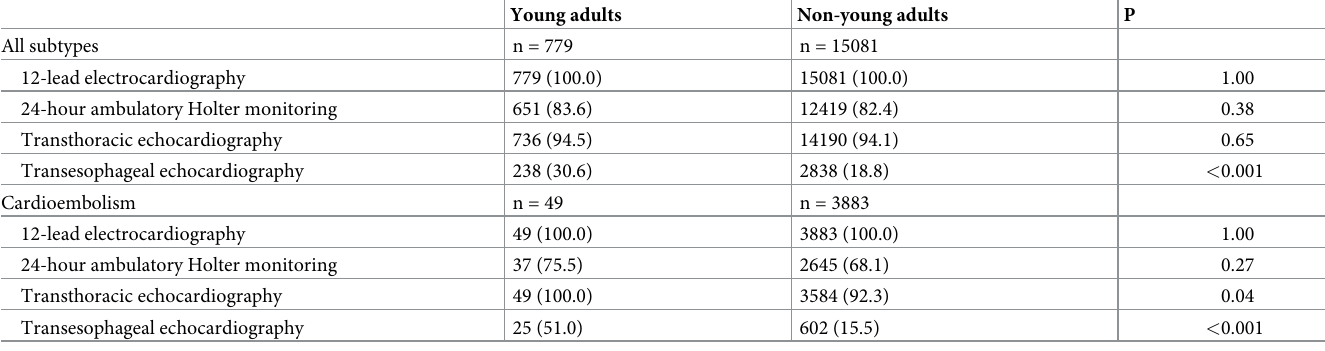
adults (Fig 3, S2 Table). Additionally, two hematologic diseases (antiphospholipid syndrome and protein S deficiency) were identified as more frequent causes in young patients than in non-young patients. By contrast, aortic arch atherosclerotic plaques were less frequent in young adults than in non-young adults. Table 3. Cardiac assessments for stroke etiology in young adults and non-young